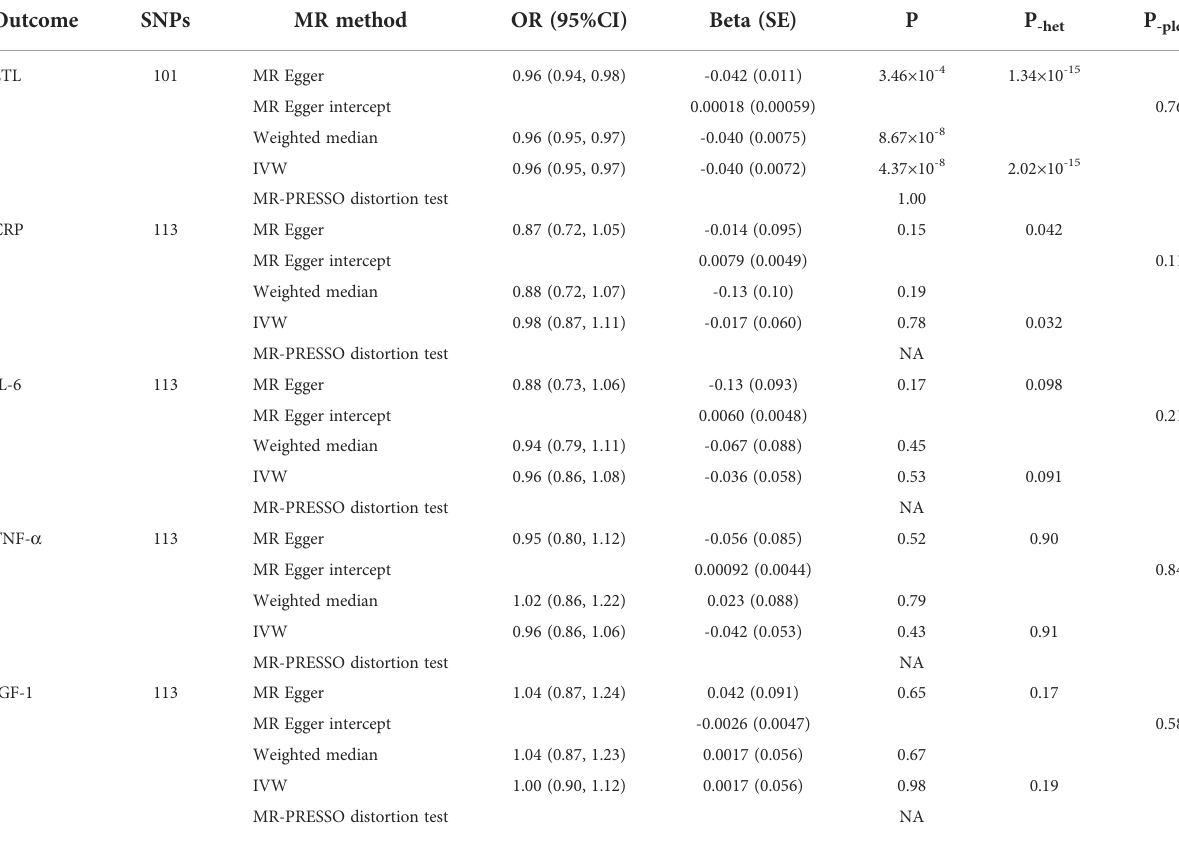
TABLE 2 Causal effects of urate level on leukocyte telomere length and in fl ammation markers using MR